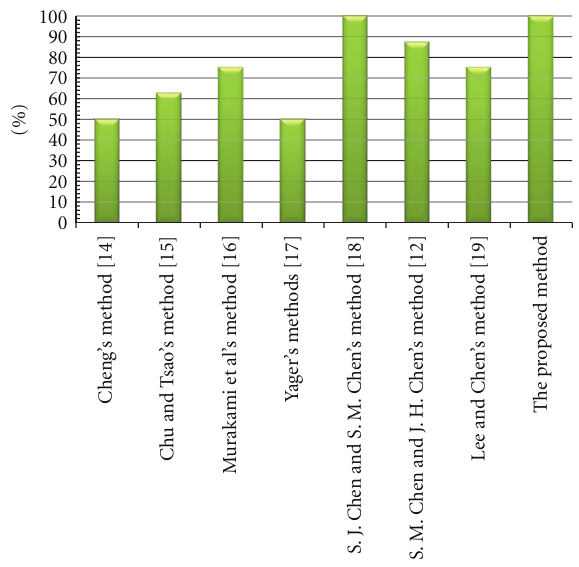
Figure 5: Percentage of correctness of the compared method according to Table 2. Table 3: Ranking of numbers given in Figure